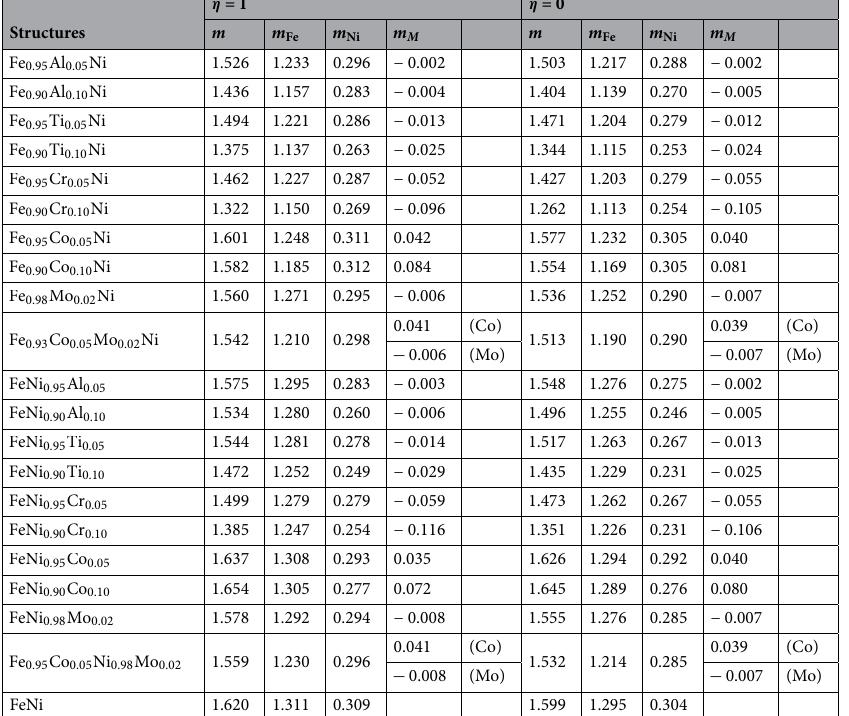
Table 2. The total magnetic moments ( m ) and partial magnetic moments ( m Fe , m Ni , m M ) (in unit of µ B per atom) of Fe 1 − x M x Ni and FeNi 1 − x M x ( x = 0.05 , 0.10) ( M = Al , Ti, Cr, Co), and Fe 0.98 Mo 0.02 Ni , FeNi 0.98 Mo 0.02 , Fe 0.93 Co 0.05 Mo 0.02 Ni and Fe 0.95 Co 0.05 Ni 0.98 Mo 0.02 for ordered ( η = 1 ) and random ( η = 0 )